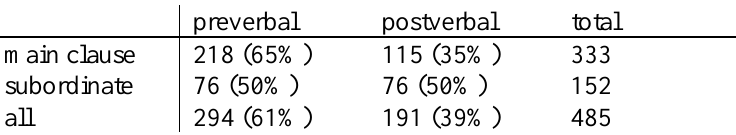
Table 5. Subject-verb inversion and sentence type